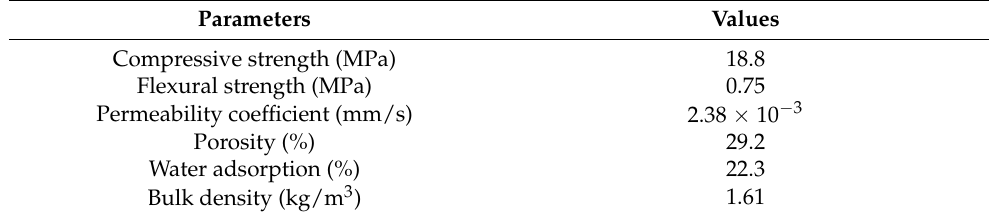
Figure 1. Schematics of laboratory-scale stormwater infiltration experiment. Table 1. Physical and hydrological properties of porous clay